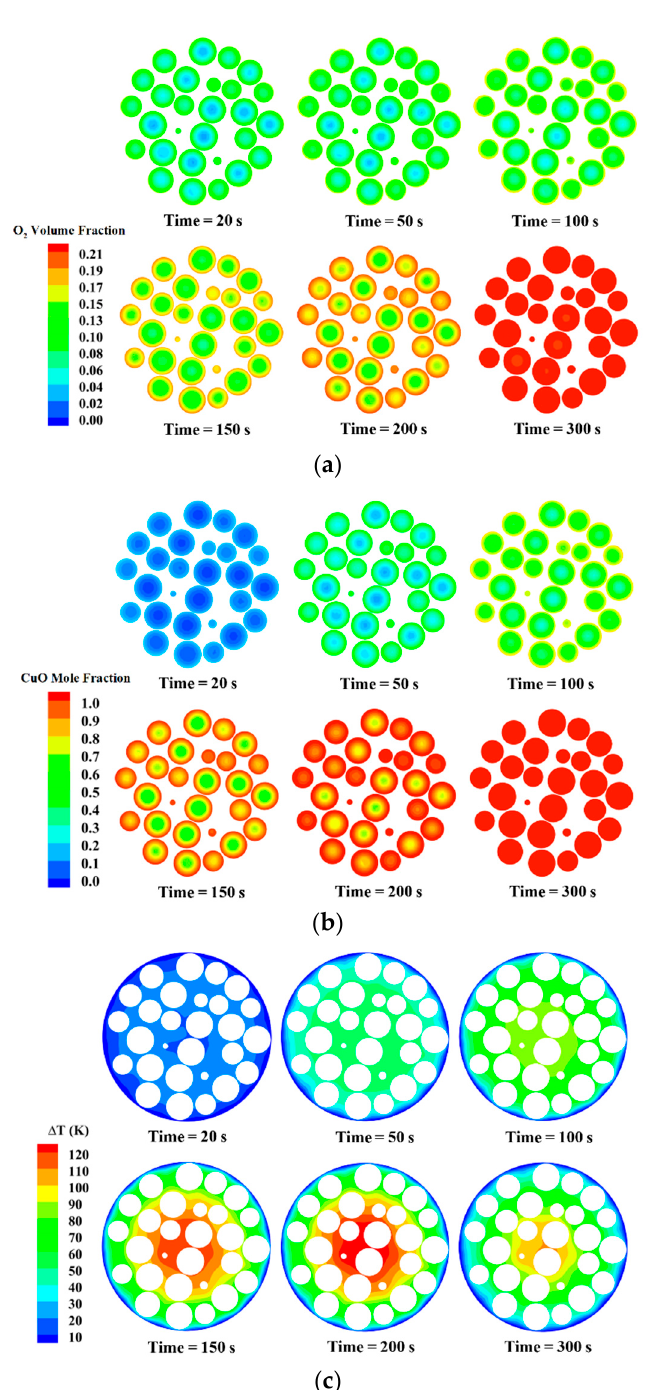
Figure 13. Contours of ( a ) O 2 volume fraction, ( b ) CuO mole fraction and ( c ) ∆ T in a radial sliced plane ( x = 50 mm) at various times.